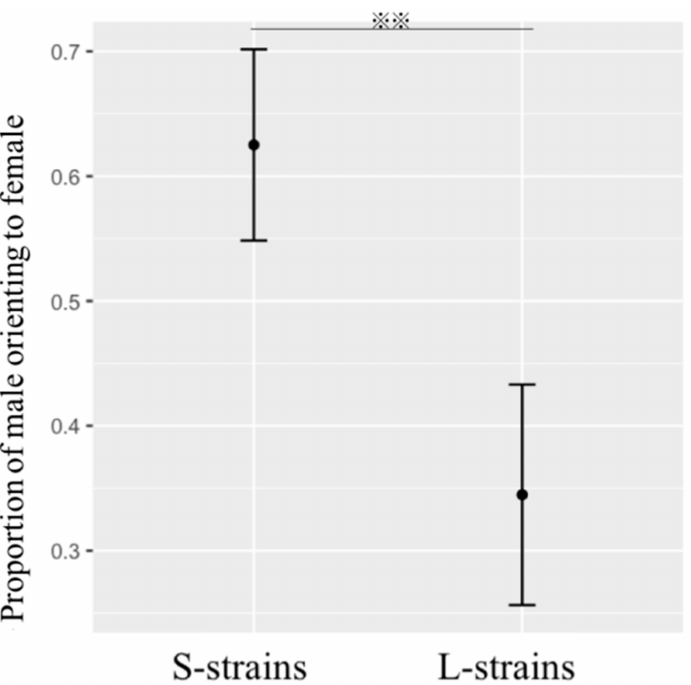
Figure 4. Di ff erences between the SPW males from S-strain versus L-strain artificial regimes of their proportion of male oriented to females, error bars are 95% confidence intervals. Asterisks indicate a significant di ff erence from the control ( p < 0.01).